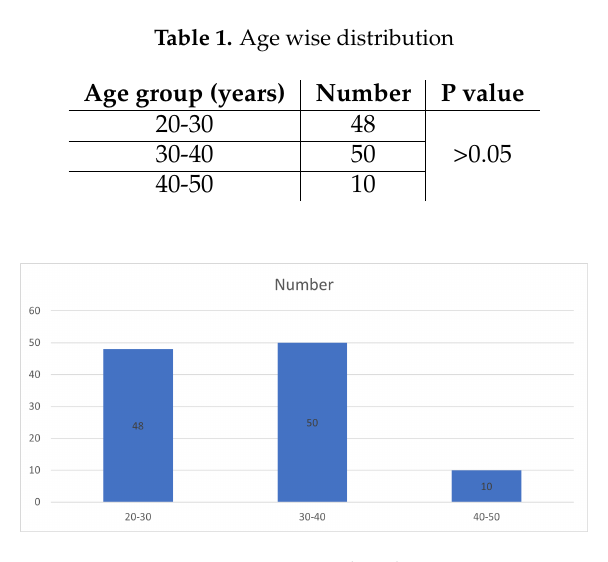
Figure 1. Age wise distribution